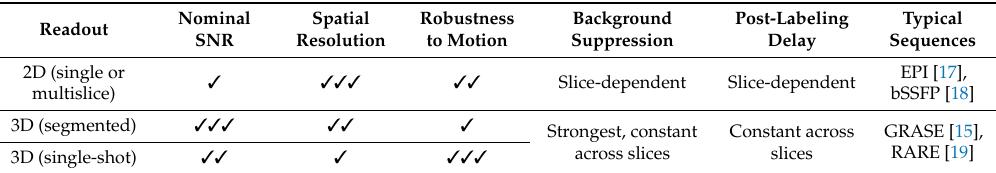
Table 2. General comparison of image readout schemes in